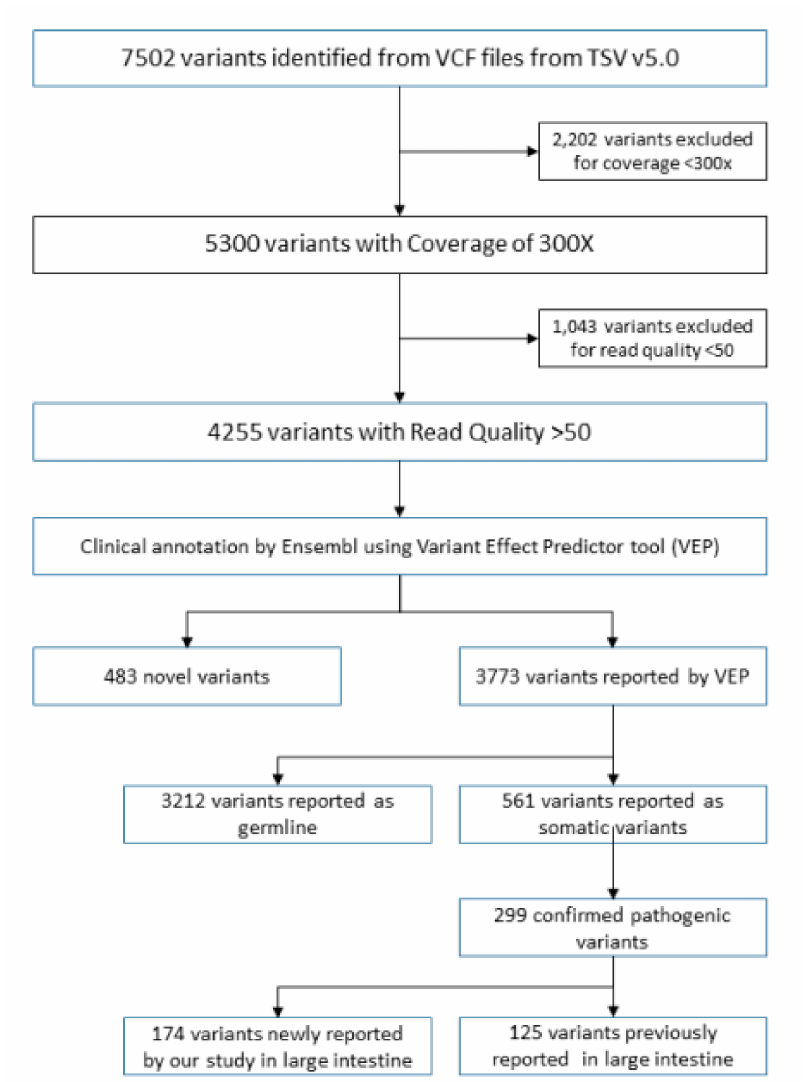
Figure 1. Variant filtration analysis workflow. Schematic illustration of variants identified in this study. A total of 483 novel variants were identified, and 561 somatic variants were observed. This study focused on pathogenic variants that were identified as novel in the large